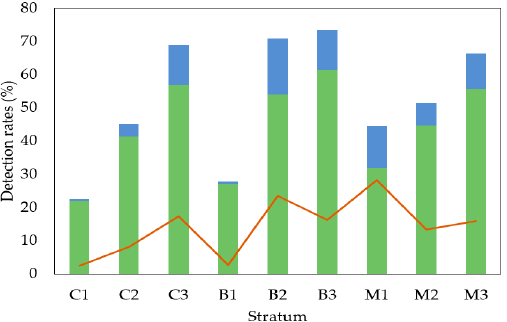
Figure 3. Detection rates of extracted (ER, blue histogram) and matched (MR, green histogram) individual trees for the strata. Commission rate (red line) is presented as well. Table 3. The overview of matching rates for each stratum and each social position of trees in percentage. Stratum Social Position of Trees